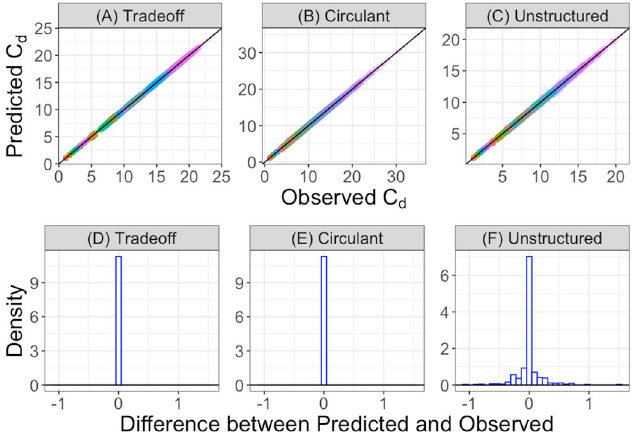
Fig 3. Analytical stability criteria predict empirical values. (A-C) We plot the value of the theoretical bound for C in the second stability criterion against the smallest C d value at which the fixed point becomes stable numerically for 100 realizations of the random matrices comprising C , P and ~ P while varying the standard deviation (colors) and mean (shapes) of the off-diagonal elements of the consumption matrix. The different panels are for the three different parameterizations of the consumption and production matrices ((A) is the tradeoff parameterization, (B) is the circulant parameterization and (C) is the unstructured parameterization). Parameters: S = 15, n = r = 1, θ = 0.5, � ii = = 1 for i 6¼ j in all panels. For each of the different matrix parameterizations, we first sample the 0.05 and � ij consumption coefficients from uniform distributions with mean given by the average consumption value (1, 3, or 5 in these simulations) and the specified standard deviations so that the coefficients of variation in consumption ffiffiffi p ffiffiffi p coefficients vary from 0 : 001 = 3 to 1 = 3 . Then, we impose the constraints for the tradeoff and circulant parameterizations afterwards. (D-F) Histograms of the differences between the predicted and observed values in panels A-C in each of the three parameterizations when the average consumption coefficient is 5 and the coefficient of ffiffiffi p variation in consumption coefficients is 1 = 3